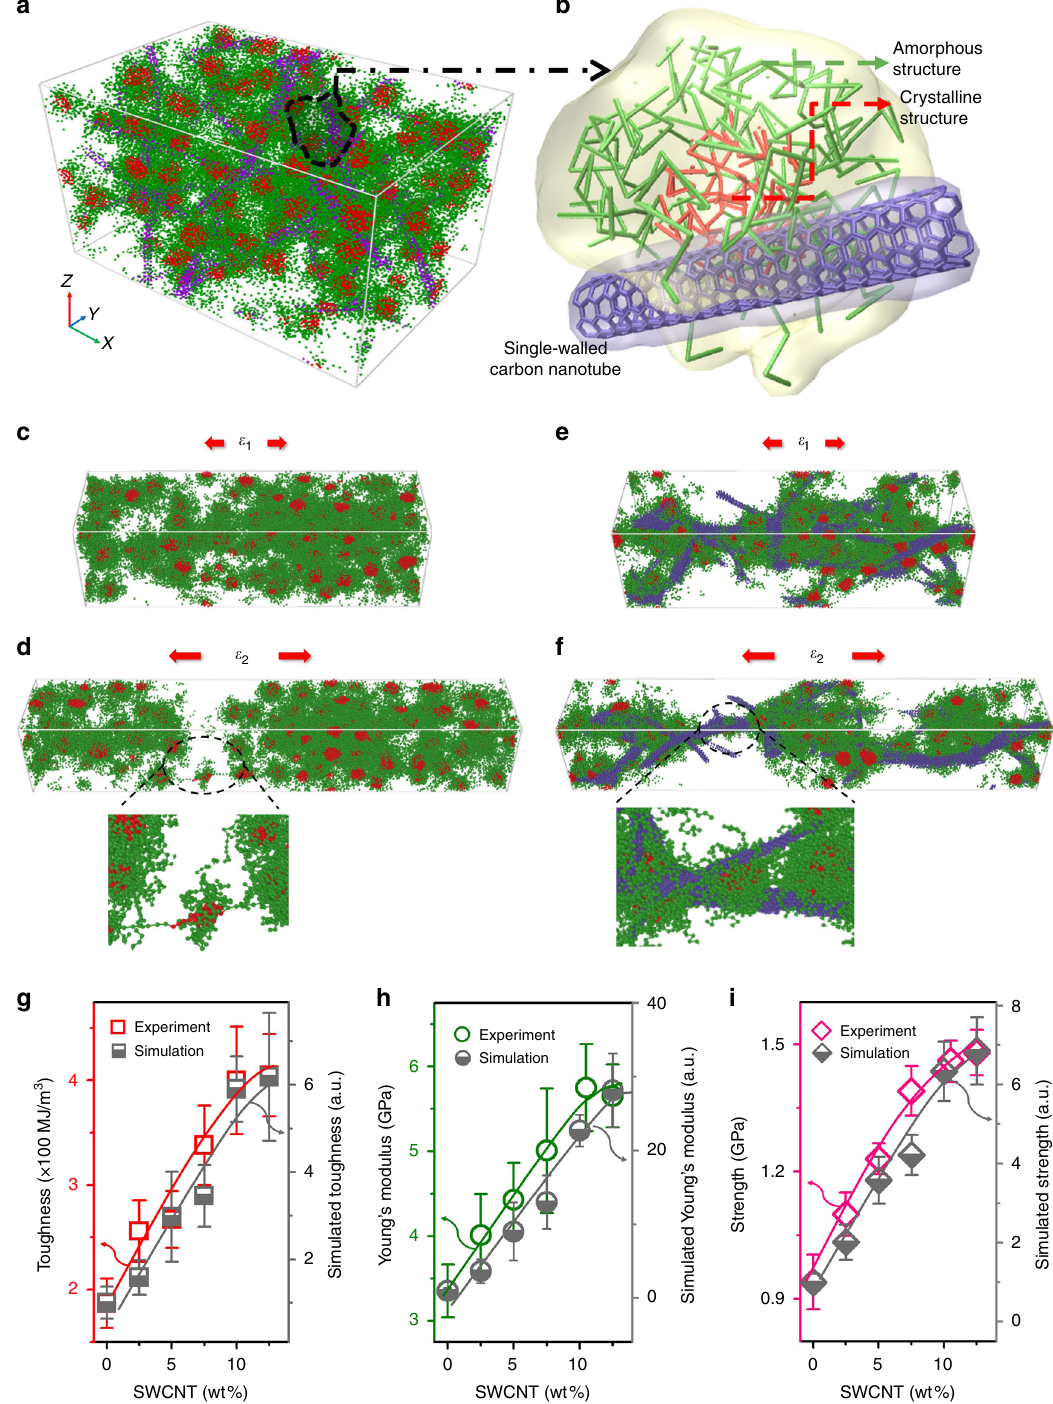
Fig. 2 A typical mechanical test of the silk-SWCNT nanocomposite in DPD simulation. a , b Show a snapshot of the coarse-grained S-silk composite. Red: crystalline structure, beta-sheet structure; green: amorphous structure (3 1 -helices and beta-turns); purple: SWCNT. c – f DPD-simulated images showing the structural evolution of natural S-silk ( c , d ) S-silk composite@10% SWCNT ( e , f ). Along the x -axis with increasing strain, ɛ 1 < ɛ 2 . ɛ 2 is the critical strain at which spider silk is broken. Because of the hydrophobic interactions between SWCNT and spider silk, the S-silk composite has better mechanical properties than natural S-silk. g – i Graph shows Toughness, Young ’ s modulus and strength increased with increasing wt% of SWCNT, indicating that SWCNT is critical for improving the mechanical properties of the S-silk composite. DPD simulation and experiments agree well. The error bars of g – i for experiments show standard deviations based on 50 independent samples. The error bars of g – i for simulations show standard deviations based on 5 independent